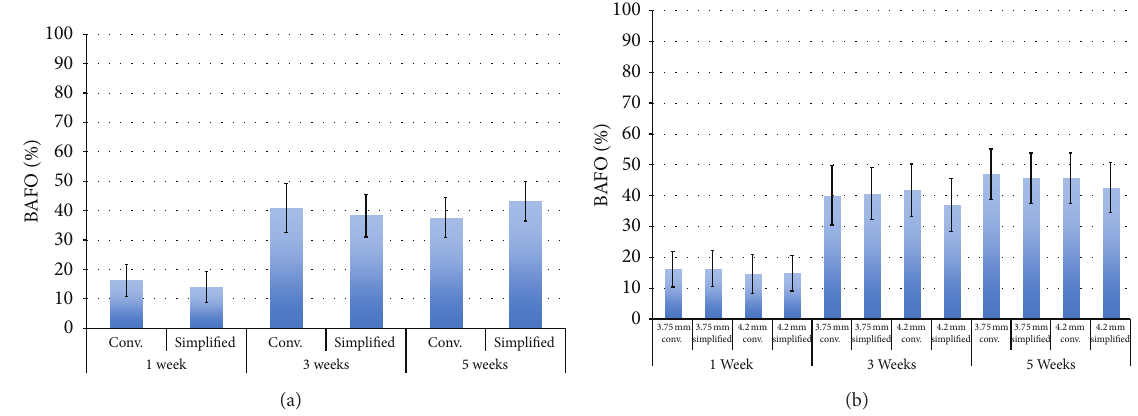
Figure 2: (a) Results for bone area fraction occupancy (BAFO) (mean ± 95% CI) as a function of drilling technique and time in vivo where no significant differences were observed between groups for each time point in vivo . (b) Results for BAFO (mean ± 95% CI) as a function of drilling technique, time in vivo , and implant diameter. No significant differences were observed between groups for each time point in vivo .